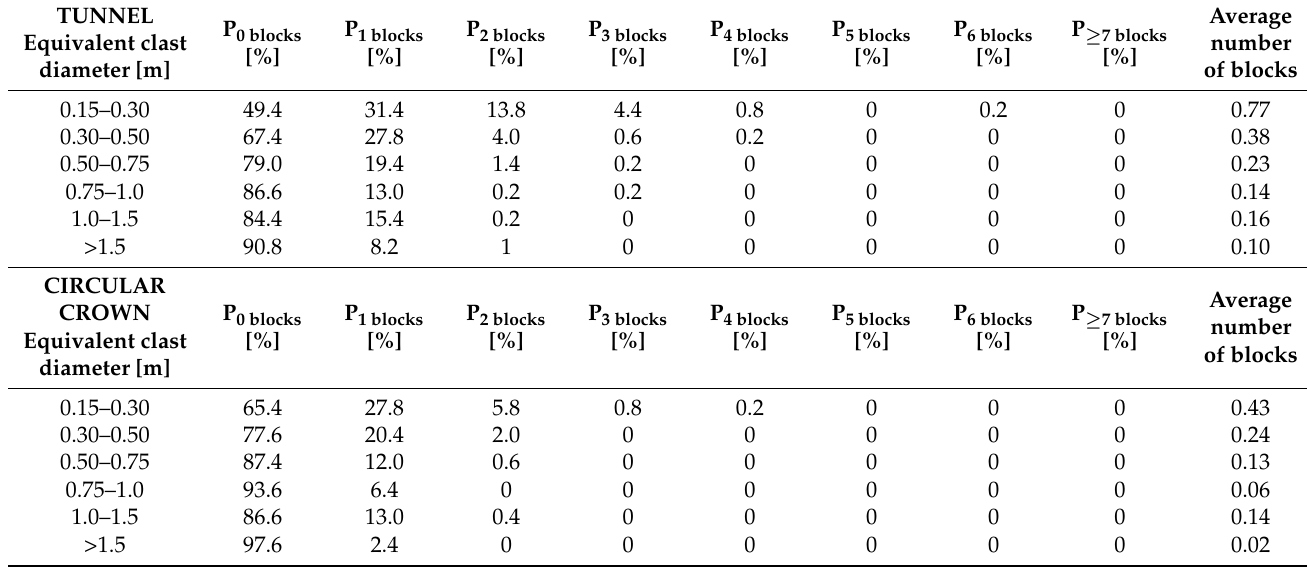
Table 2. Probability, P, of encountering n blocks (with n from zero to more than seven) with an intersection area greater than the threshold value A_thr1, equal to 0.0177 m 2 . The average number of blocks corresponding to each equivalent clast diameter is also provided. The results are related to the entire tunnel section (table above) and to the circular crown (table below). These results are contained in the output text files “Probability” and “N_Average” of Table 3.